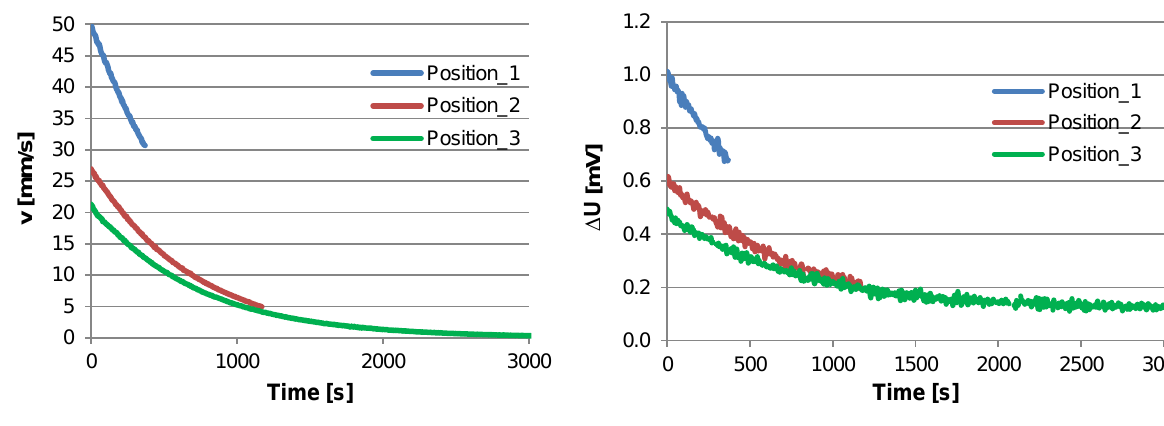
Figure 4. ( left ) Induced air velocities vs. time, ( right ) the correspondent sensor output voltage differences vs. time for three different positions of both bottles regarding their height